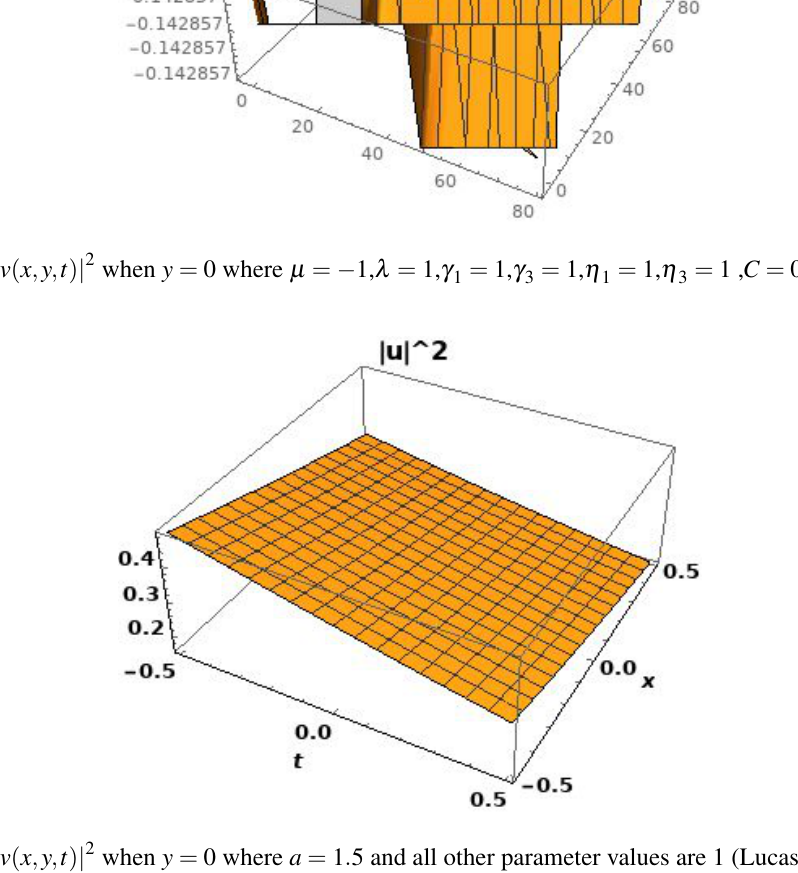
Fig. 3 3D-plot for | v ( x , y , t ) | 2 when y = 0 where a = 1 . 5 and all other parameter values are 1 (Lucas combined hyperbolic